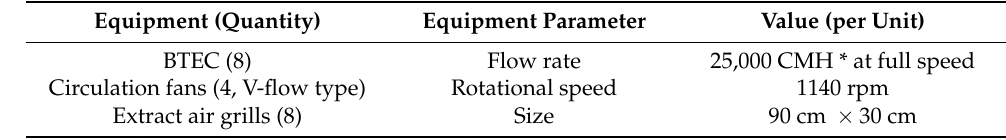
Table 2. Greenhouse HVAC system